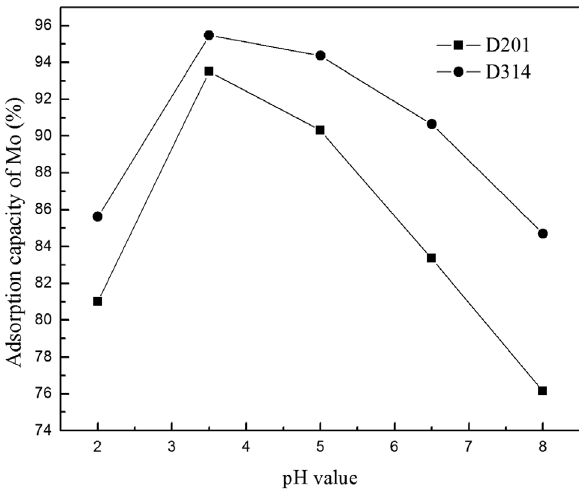
Figure 4: The deposition curve of D314